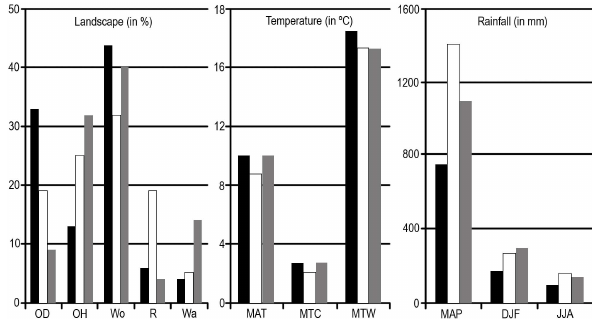
Fig. 7. Environmental and climatic comparisons between Canyars (black bar), El Portal´on (white bar) and Cueva del Conde (grey bar). Data for El Portal´on are from L´opez-Garc´ıa et al. (2010a) and for Cueva del Conde are from L´opez-Garc´ıa et al. (2011b). Abbrevi- ations: OD, open dry; OH, open humid; Wo, woodland; R, rocky; Wa, water edge; MAT, mean annual temperature; MTC, mean tem- perature of the coldest month (January); MTW, mean temperature of the warmest month (July); MAP, mean annual precipitation; DJF, mean winter precipitation; and JJA, mean summer precipitation.